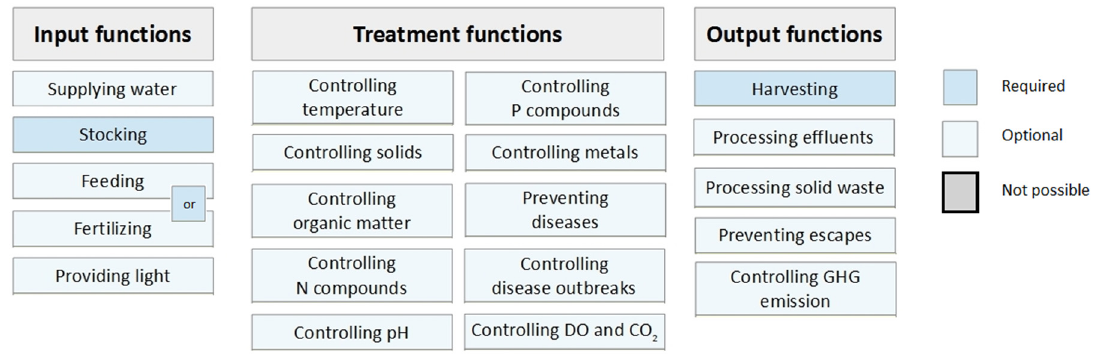
Figure 4. The system map describing semi-intensive aquaculture systems.